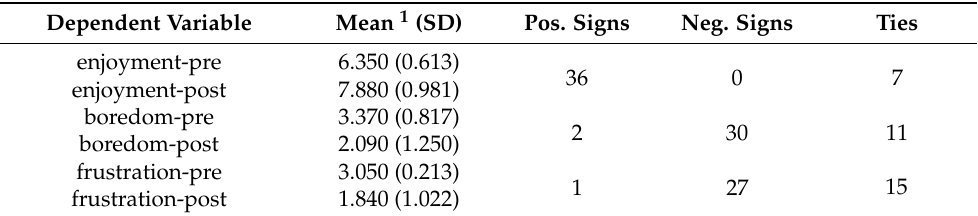
Table 3. Descriptive statistics and signs (Wilcoxon-signed-rank-test) for the for the activity emotion change